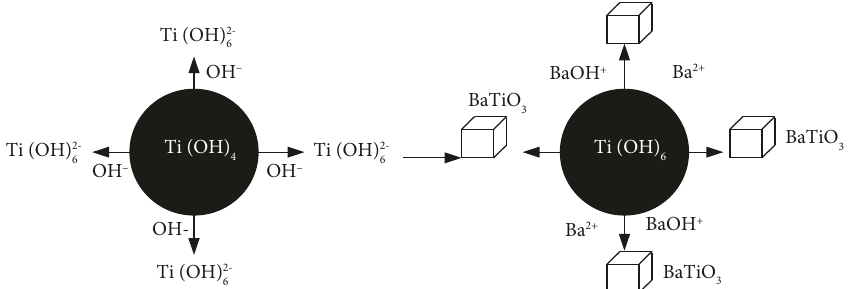
Figure 3: Formation mechanism of barium titanate